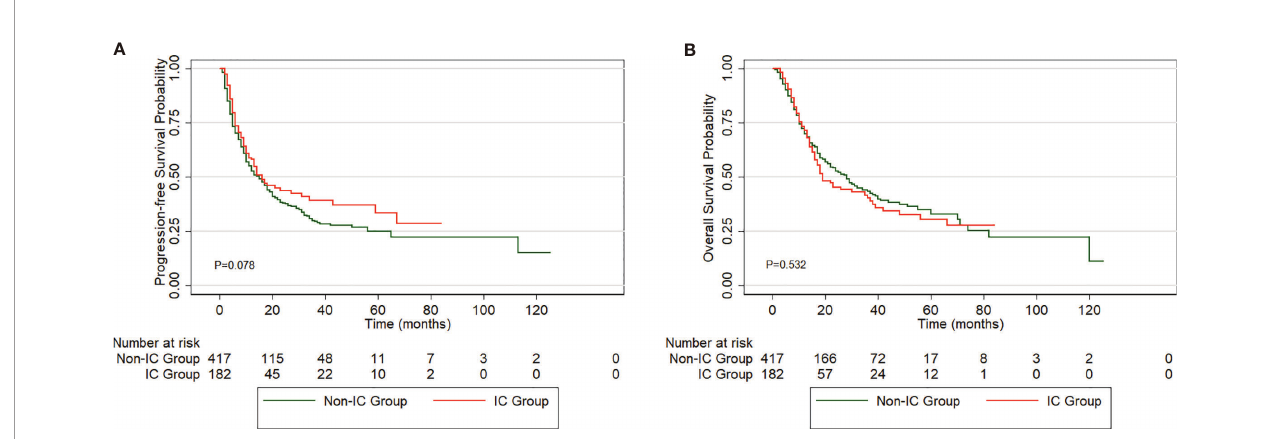
FIGURE 2 | Comparison of PFS (A) and OS (B) in esophageal squamous cell carcinoma (ESCC) patients between the two groups.